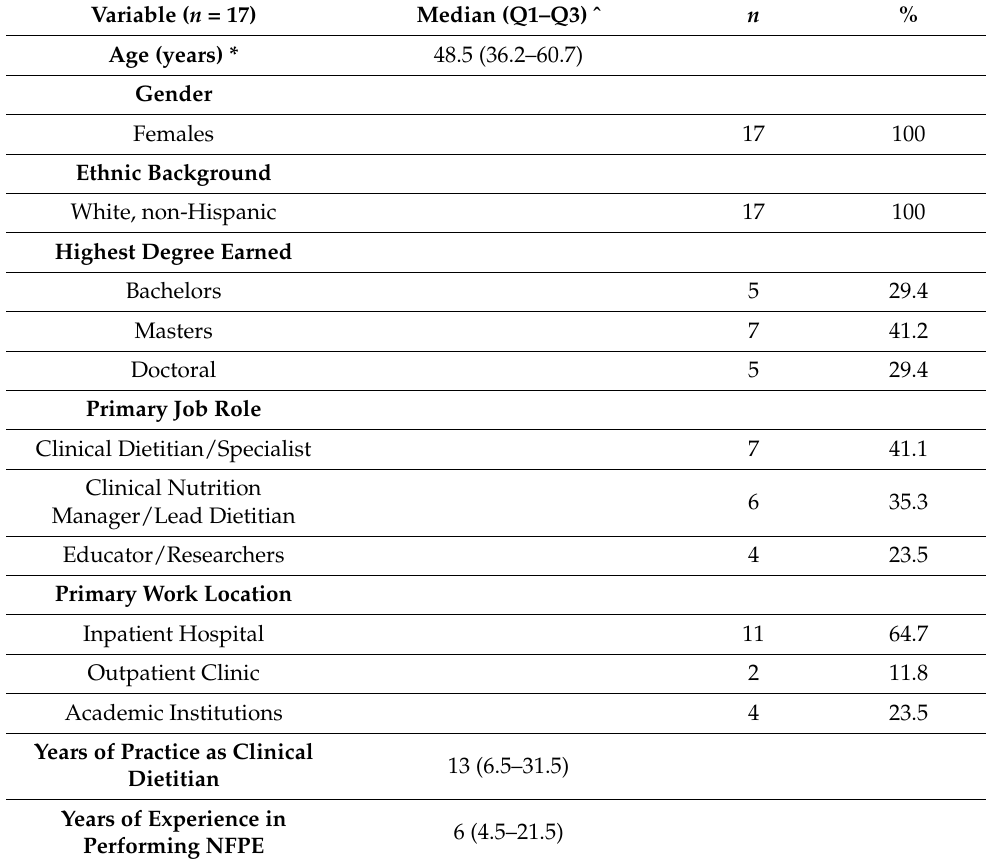
Table 1. Demographic Characteristics of Content